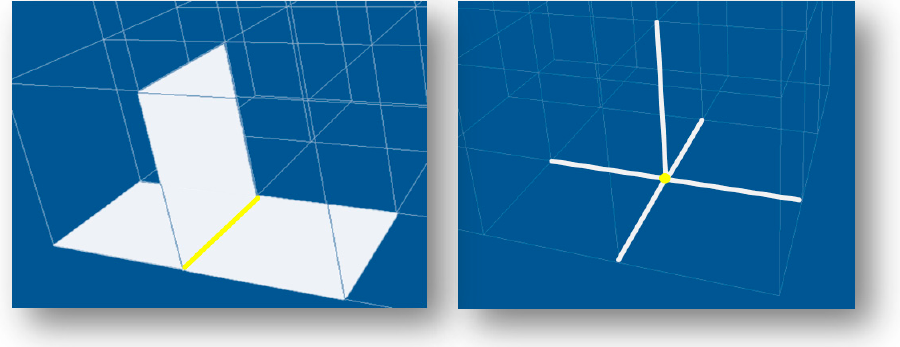
Figure 9. Common edge and vertex.